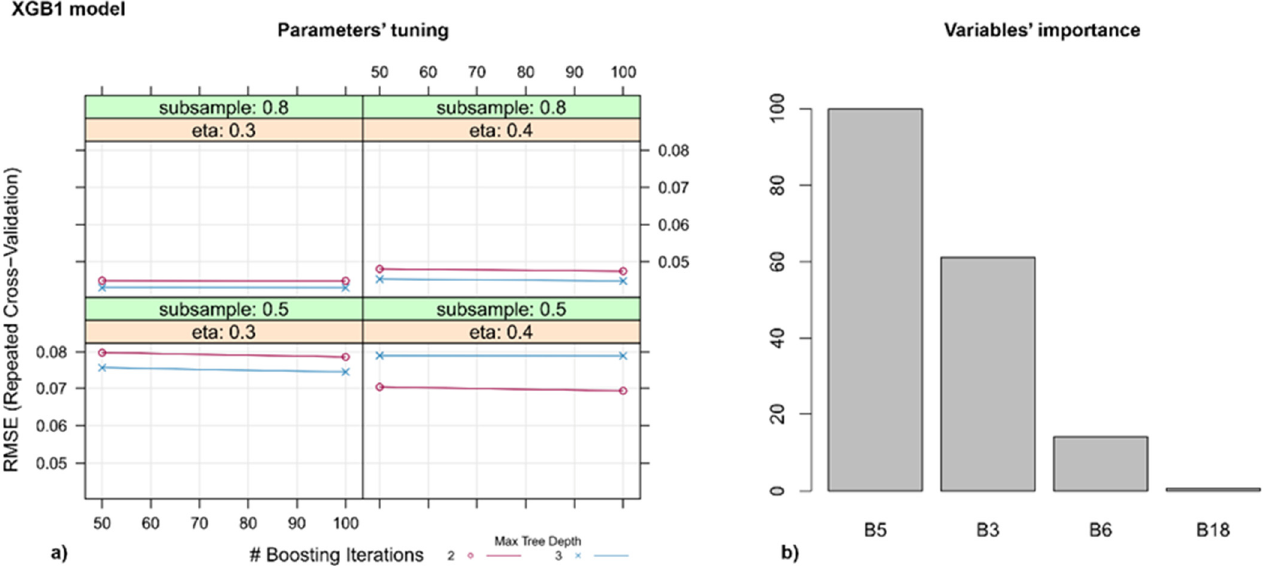
Figure 7. XGB1 model parameters’ tuning procedure yielded the following optimal setting: 50 boosting iterations, subsample = 0.8, eta = 0.3, and maximum tree depth = 3 ( a ). The most important variables in explaining the differences between the infected and healthy samples, in order of decreasing importance, are B5 (R408.85 nm), B3 (R403.09 nm), B6 (R411.74 nm), and B18 (R446.45 nm) ( b ).